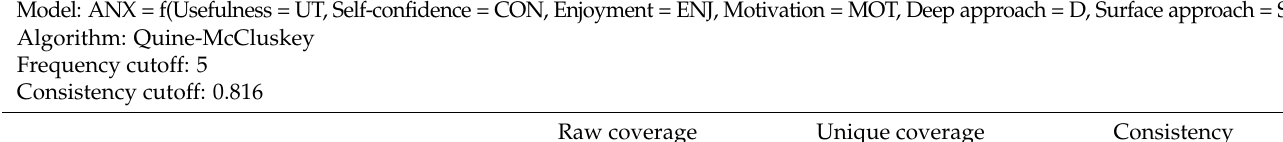
Table 1. Configurations for achieving low levels of anxiety (ANX) and high levels of anxiety